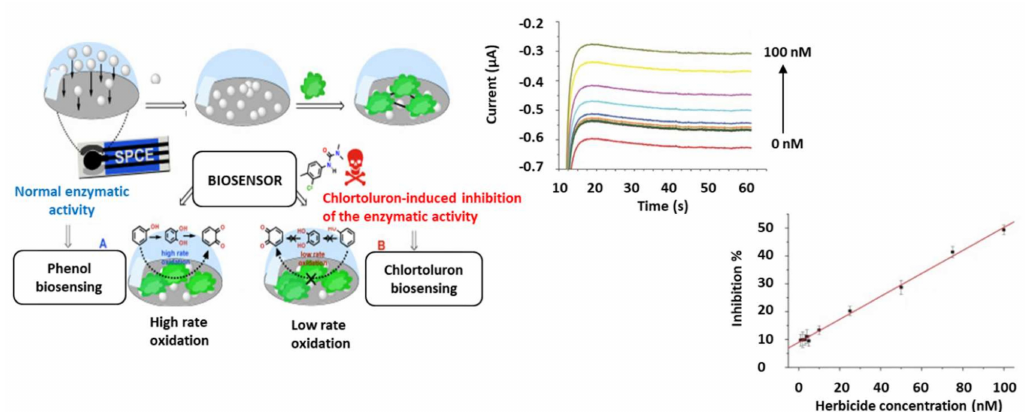
Figure 3. Enzyme inhibition biosensors for pesticides detection on screen-printed electrodes. (Left) scheme of a biosensor for Chlortoluron using a SPCE modified with ZnO NPs for Tyr enzyme immobilization; (Right) Chronoamperometric (CA) responses and calibration curve of inhibition % vs. concentration of herbicide. Reprinted from [109], Copyright 2015, with permission from